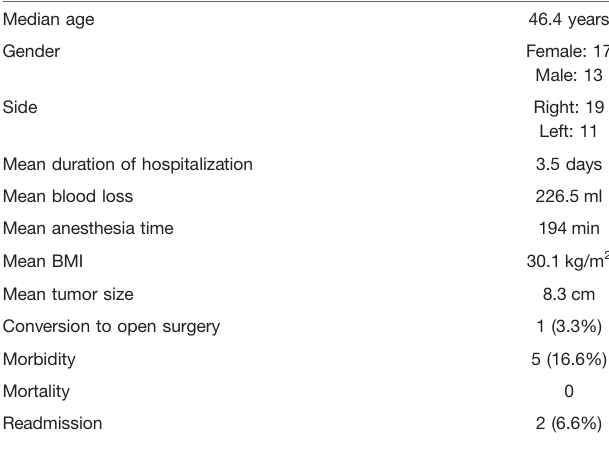
TABLE 1 | Demographic characteristics of 30 evaluated